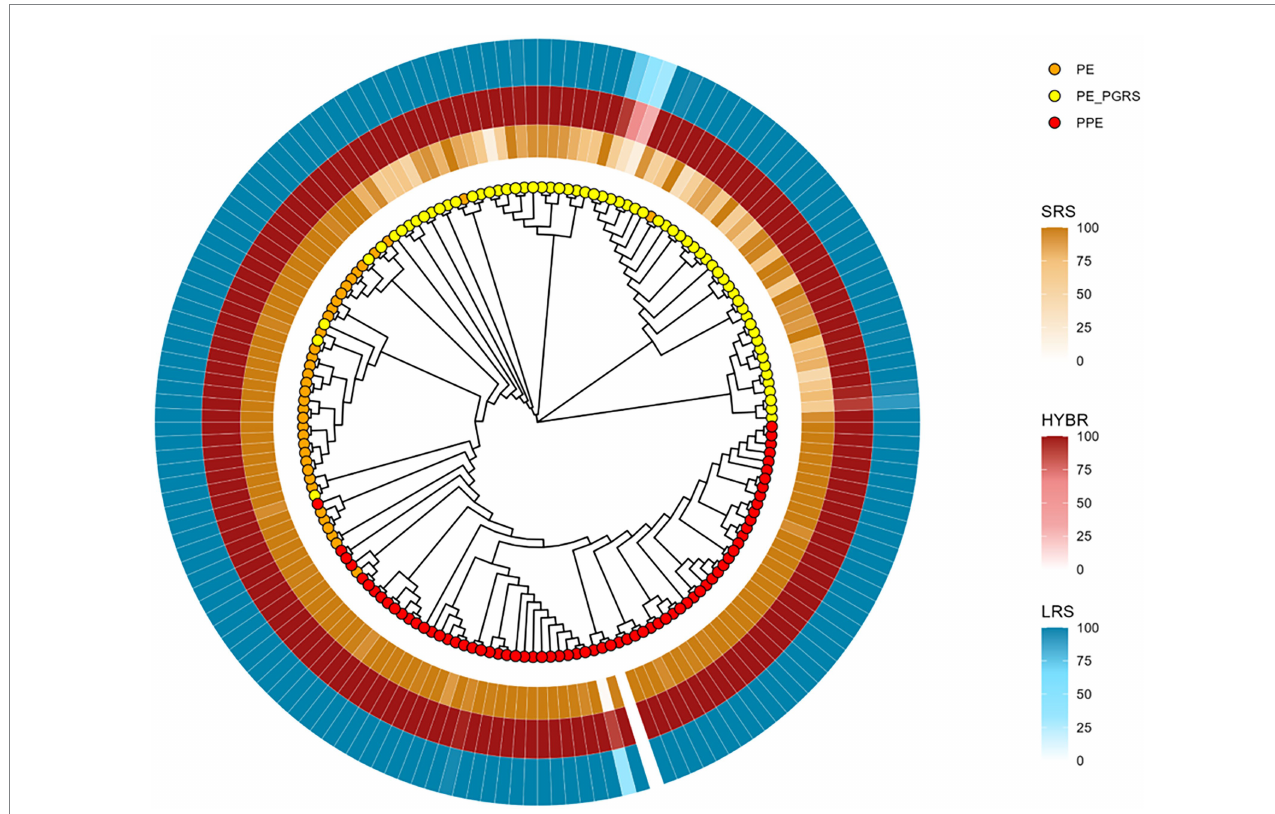
FIGURE 3 PE/PPE genes neighbor-joining tree based on multiple sequence alignment result. Orange tips: PE genes; Yellow tips: PE_PGRS genes; Red tips: PPE genes. Yellow layer: SRS 8X breadth coverage; Red layer: HYBR 8X breadth coverage; Blue layer: LRS 8X breadth coverage.